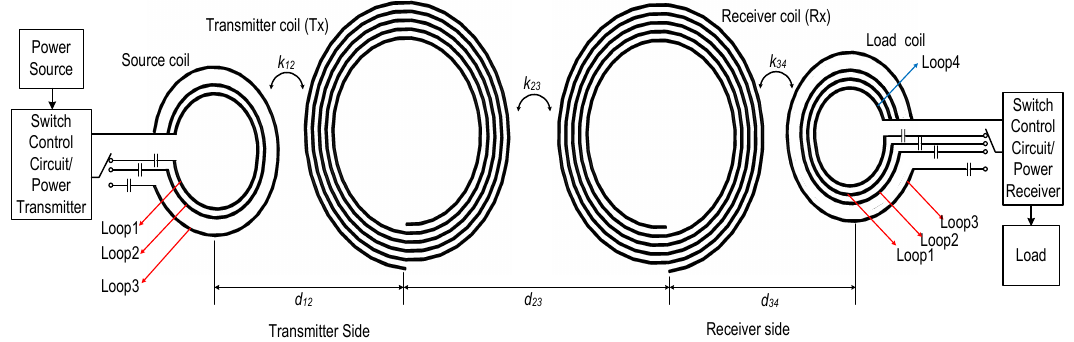
Figure 3. Proposed WPT system with the multiple loop coil switching technique.